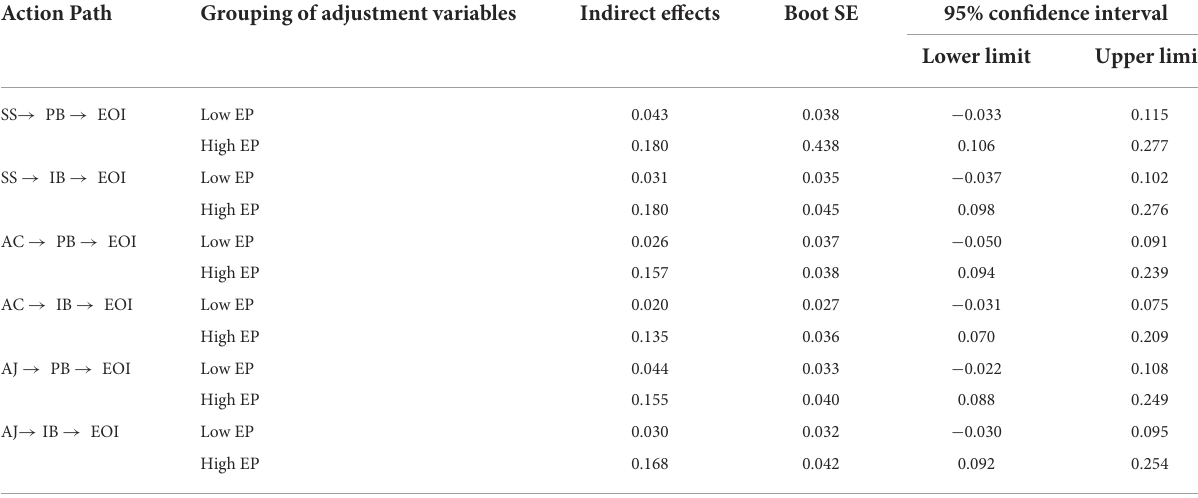
TABLE 6 Results of the mediating effect of being moderated (Bootstrap method) test. Action